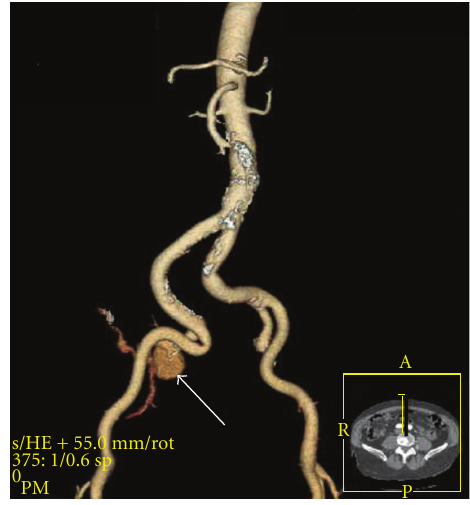
Figure 2: Reconstructed image of a pseudoaneurysm arising from the right internal iliac artery